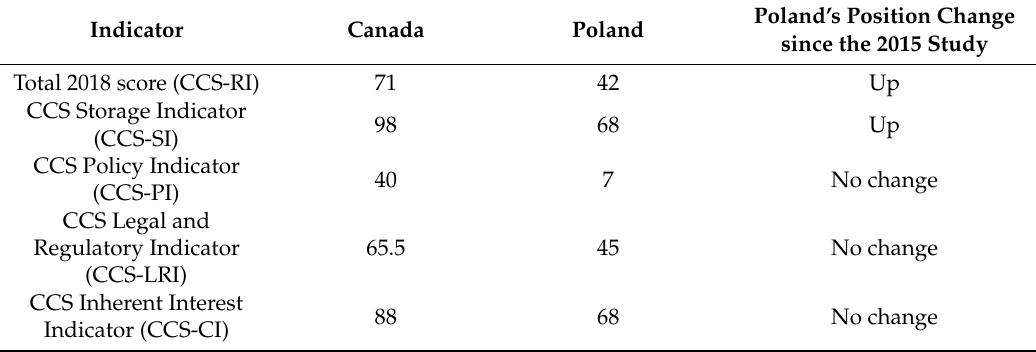
Table 2. Poland versus Canada (the leading state) performance